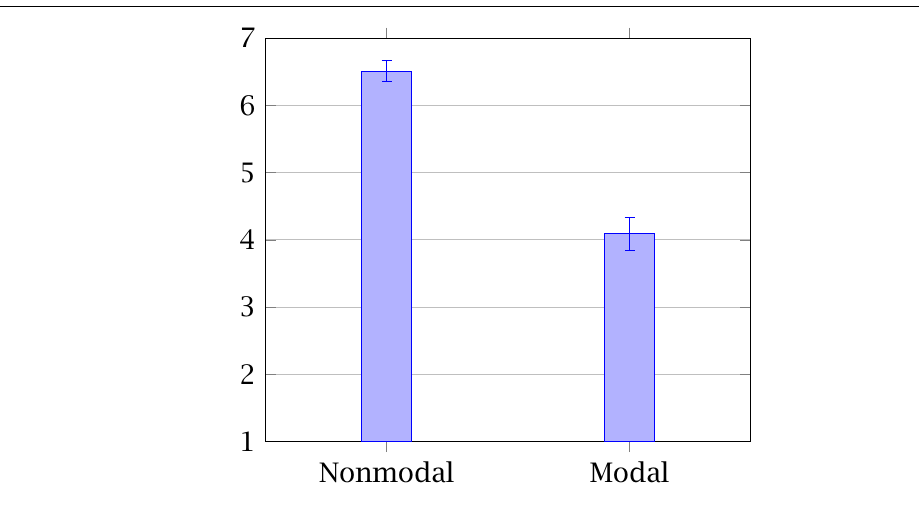
Mean ratings by condition for Experiment 3 . Error bars show standard error of the